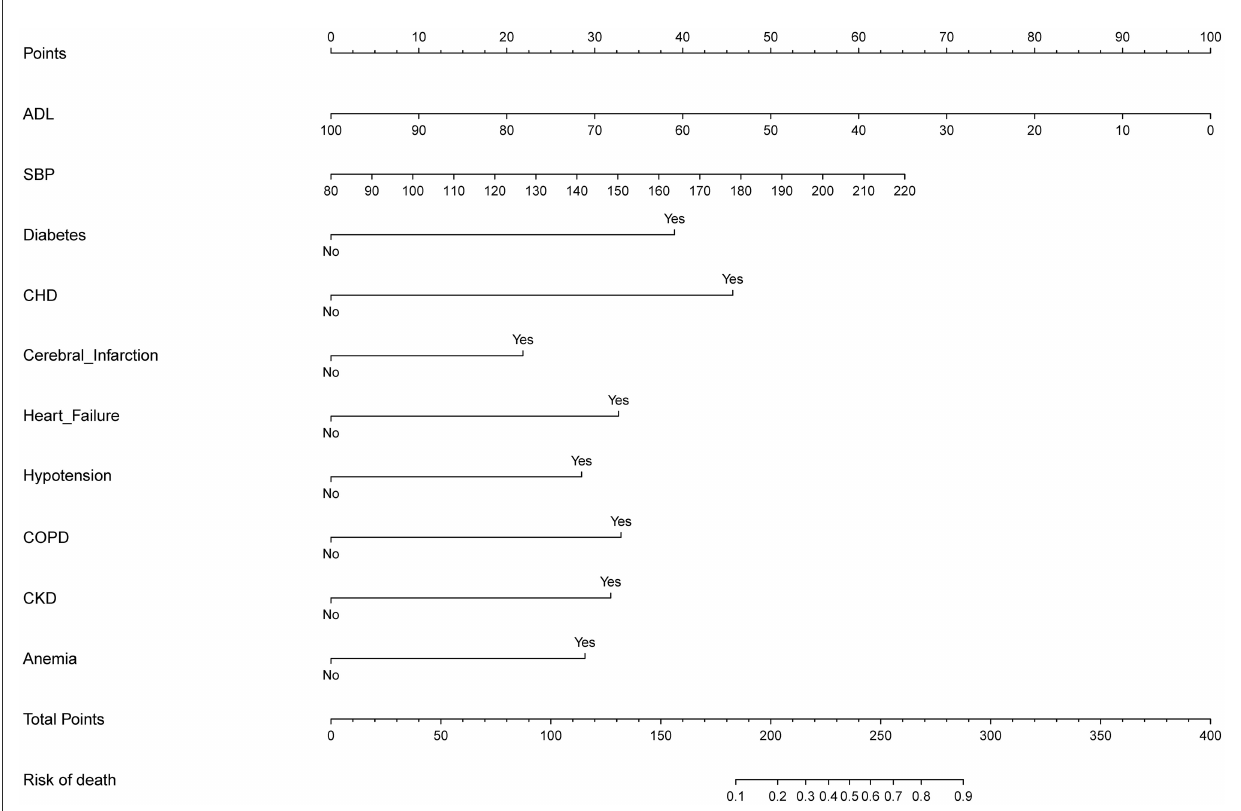
FIGURE3 Developed predictor model of in-hospital death nomogram. Nomogram model for predicting individual risk of death in patients with AD. The death risk nomogram was developed in the cohort, with ADL, with SBP, with complications of DM, with complications of CHD, with complications of heart failure, with complications of hypotension, with complications of COPD, with complications of pneumonia, with complications of CKD, and complications of anemia. For all patients adding up the points identified on the point scale for all eight indicators. Then the sum is located on “Total Points” axis. DM, diabetes mellitus; CHD, coronary heart disease; COPD, chronic obstructive pulmonary disease; CKD, chronic kidney disease; ADL, activities of daily living; SBP, systolic blood